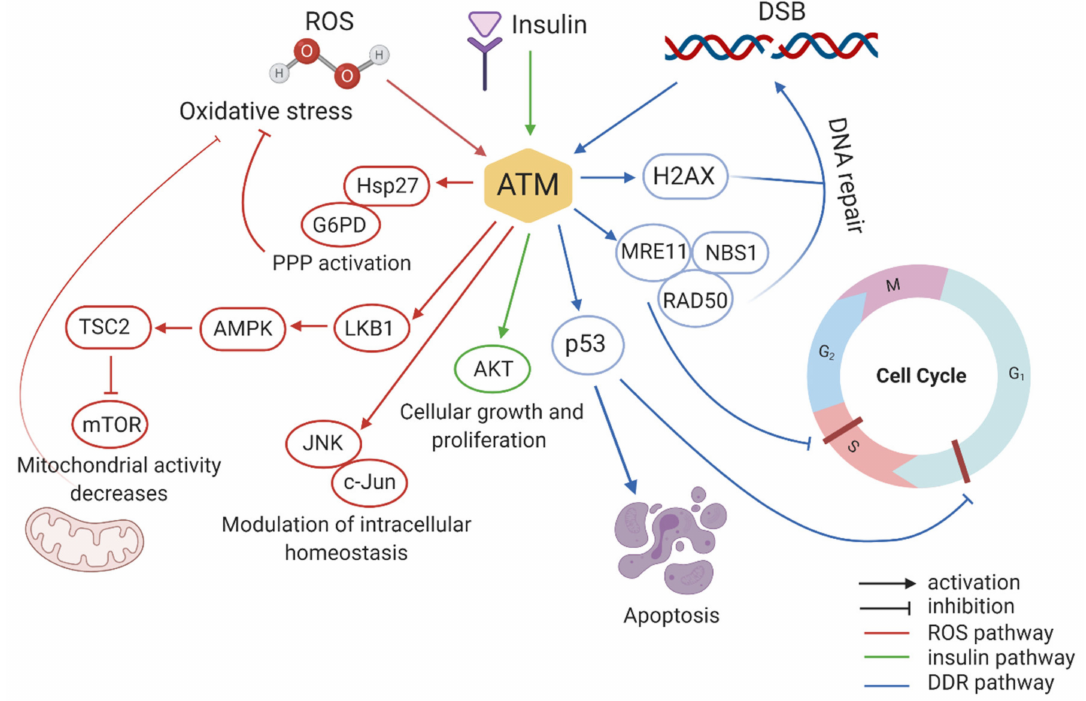
Figure 1. Selected summary of the ATM signalling network. A non-comprehensive schematic of the di ff erent ataxia-telangiectasia mutated (ATM) signalling pathways described in the